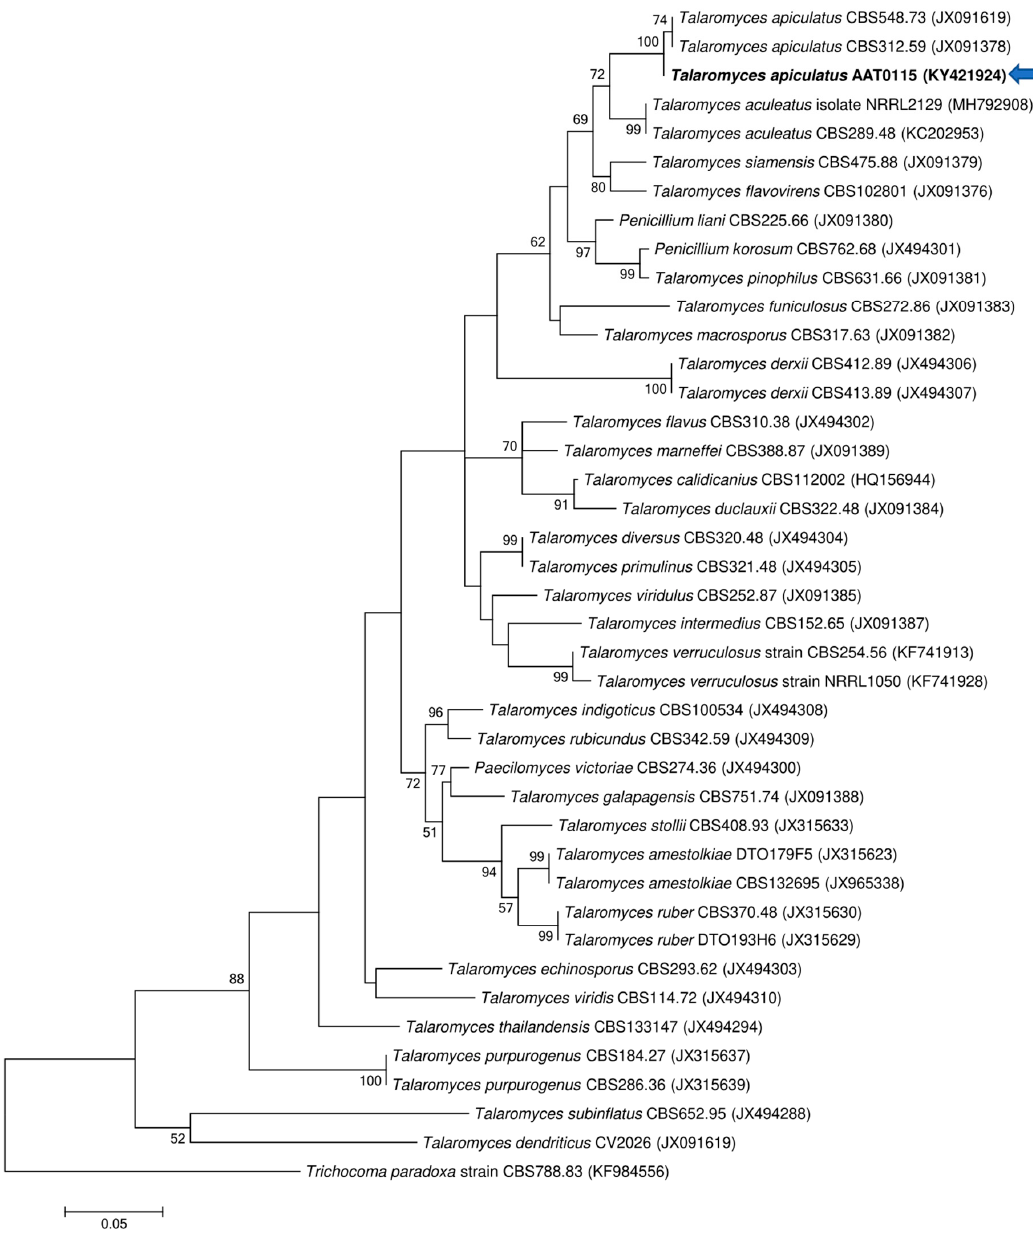
Figure 3. Phylogenetic relationship of AAT0115 and its closely related species based on beta-tubulin ( BenA ) sequences and position of the AAT0115 (in bold) (arrow). Trichocoma paradoxa CBS788.83 (KF984556) was used as the outgroup for the phylogenetic tree generated through maximum likelihood approach. Bootstrap values ≥ 50% from 1000 bootstrap repetitions are shown for the corresponding branches. Scale bars indicate estimation of 0.05 substitutions per nucleotide position for the branch lengths.